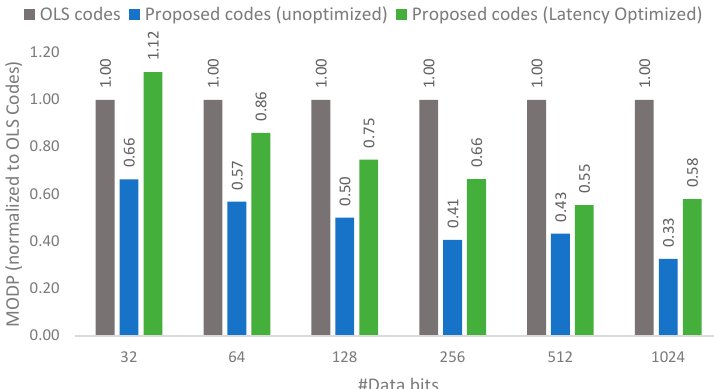
Figure 12. Comparison of memory overhead-delay product of decoder between OLS codes and proposed codes.